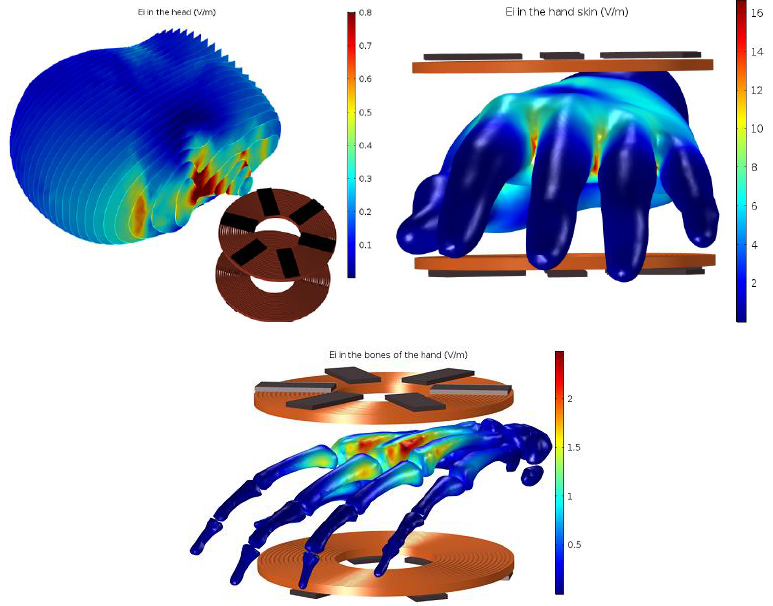
Figure 6. Induced electrical field in V / m of the head, skin and bones of the hand. Table 3. Basic restrictions for electrical induced field 𝐸 .